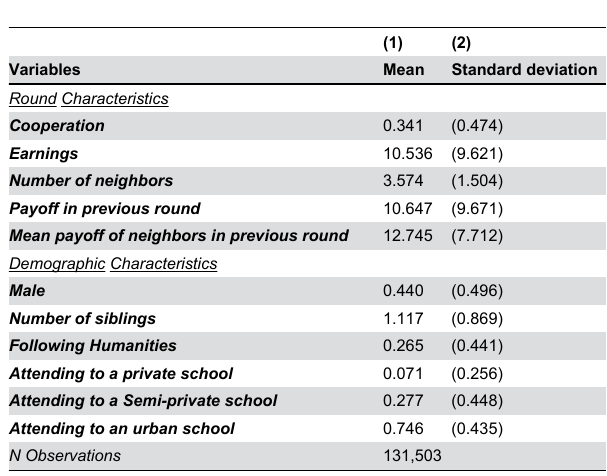
Table 1. Sum stats for personal and game characteristics.